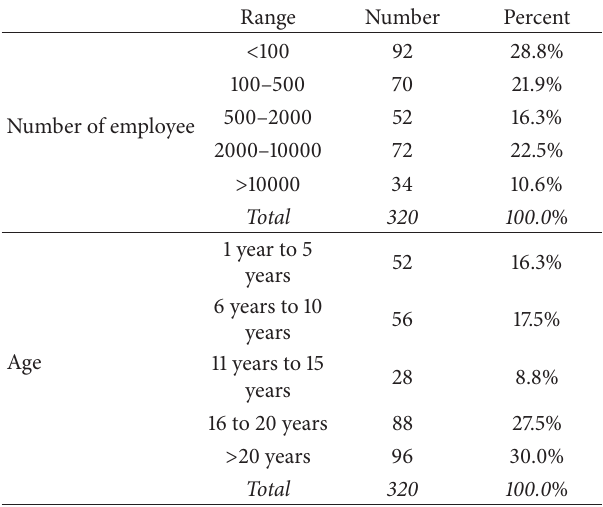
Table 2: Organizational